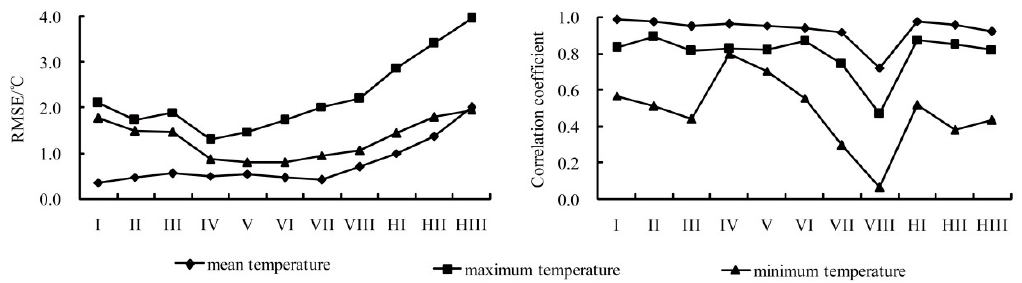
Figure 10. Root mean-square error (left) and correlation coefficient (right) of annual temperature.